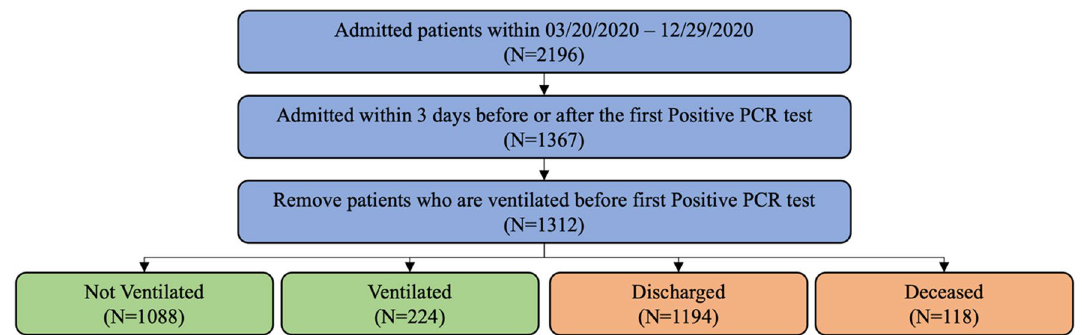
Figure 1. A flowchart of study enrollment. Composite ventilation related outcomes are represented by green boxes and Mortality related outcomes are represented by red